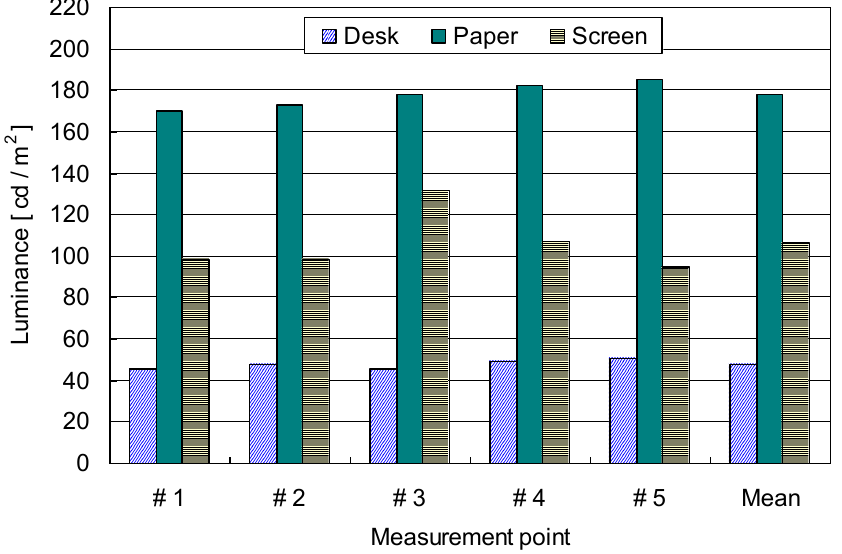
Figure 10. Variation of luminance on desktop and computer screen (750 lx